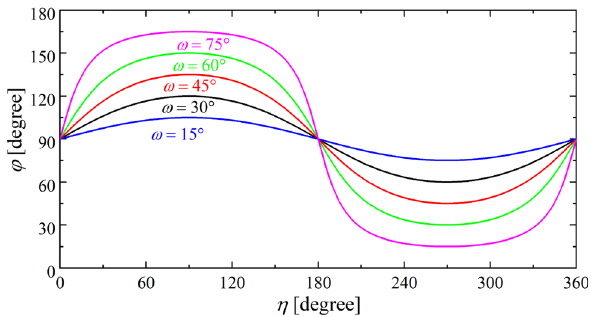
Fig. 3 The variation relationship between the photon deflection angle ϕ and polar coordinate η when observational angle ω takes different values.Clearly,thedeflectionanglesatisfiedtheconditionof π/ 2 − ω ≤ ϕ ≤ π/ 2 +